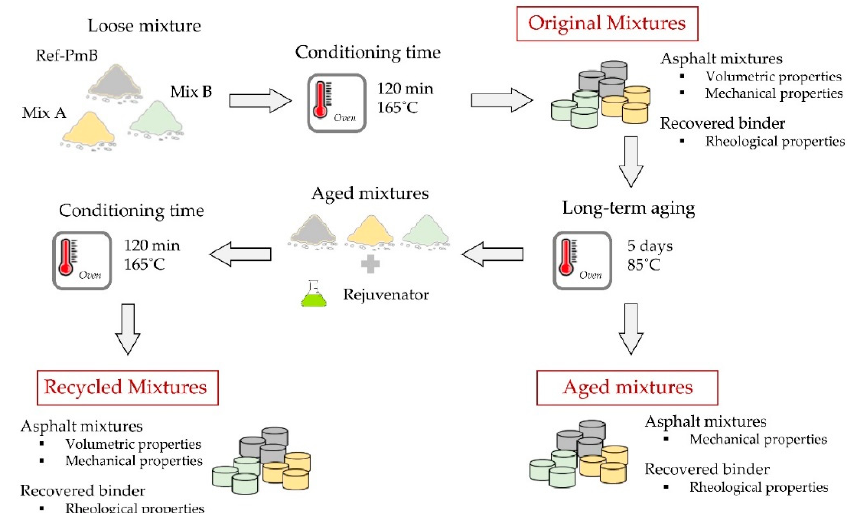
Figure 1. Methodology for the aging and recyclability potential analysis of asphalt mixtures.